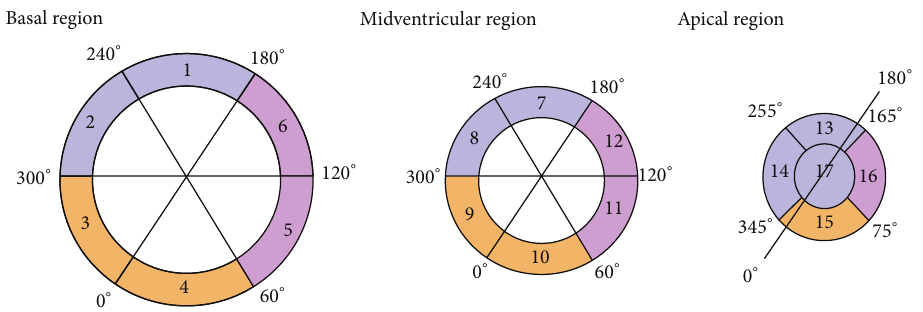
Figure 3: The figure is a diagrammatic representation of the short-axis views of the basal, midventricular, and apical regions of the ventricles in accordance with the AHA 17-segment model. The ventricles are divided into thirds along the long axis of the ventricles. The territories of left anterior descending artery (LAD), right coronary artery (RCA), and left circumflex artery (LCX) have their own color and angle.